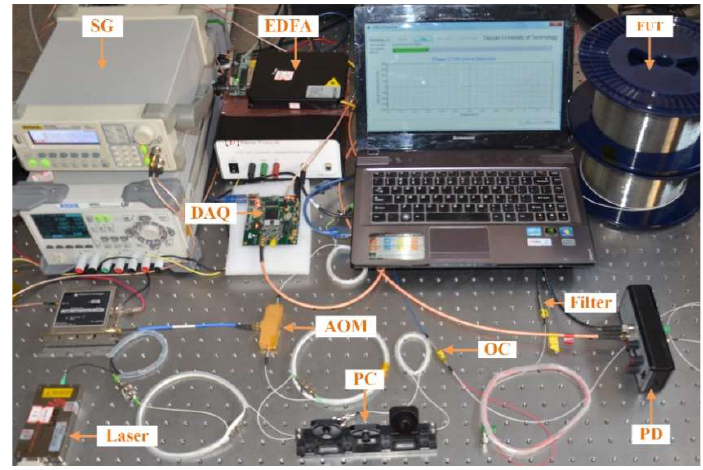
Figure 4. Experimental setup.